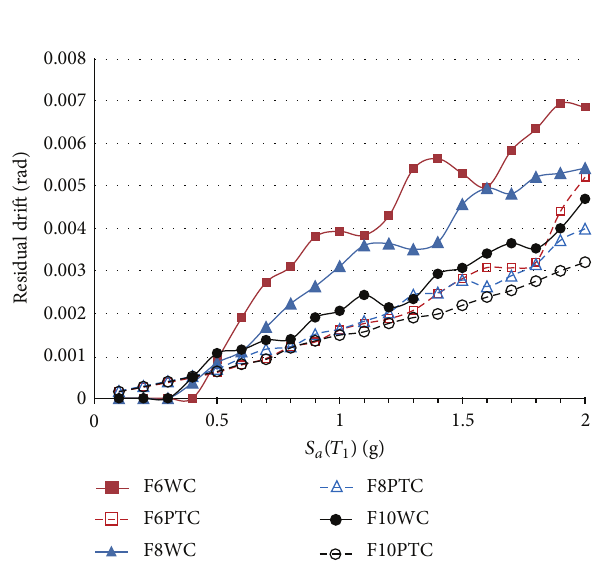
Figure 10: Median values of maximum residual interstory drift of the frames FWC and